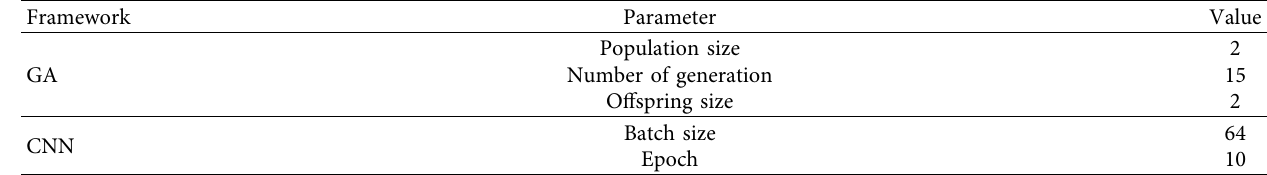
Table 3: Design of algorithm